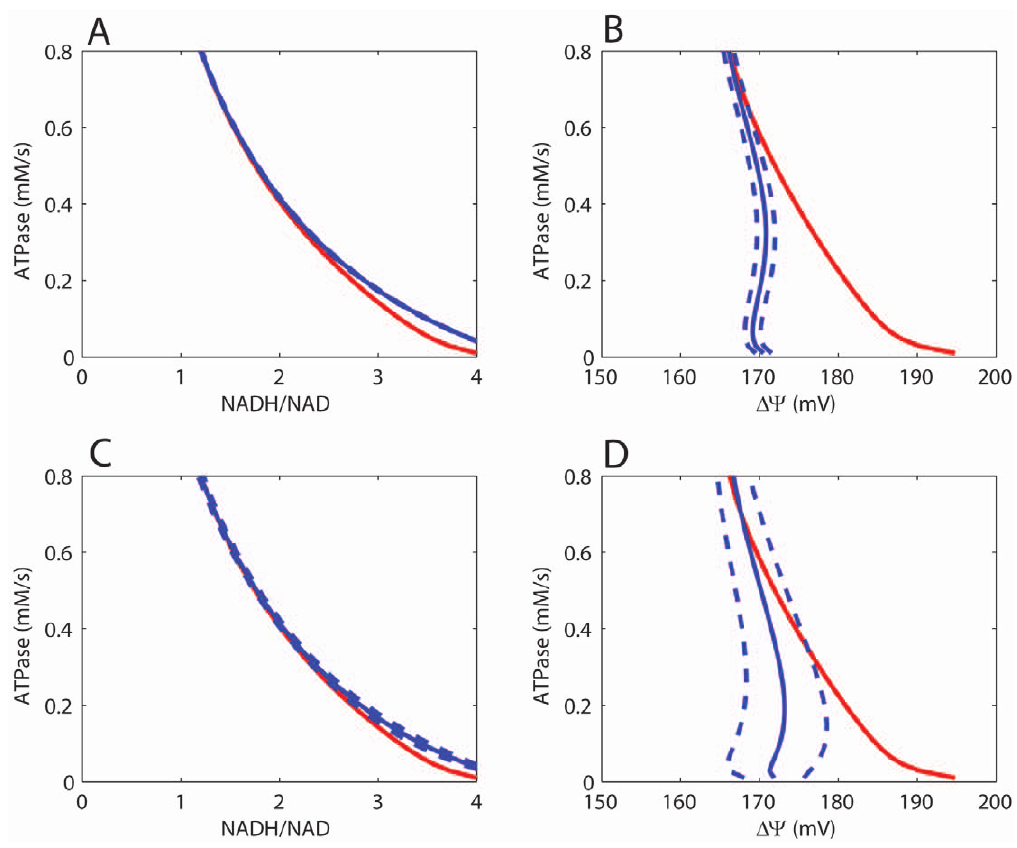
Figure 4. Model predictions of mitochondrial redox state (NADH/NAD) and membrane potential ( n Y ). Model predictions of mitochondrial redox state (NADH/NAD) and membrane potential ( n Y ) at different cellular ATP demand fluxes according to model configuration i ( A–B ) and model configuration ii ( C–D ). Model predictions are indicated as the mean (solid blue line) and SD (dotted blue line) of the 1000 simulations that were run in a Monte Carlo approach. Predictions of the original model are shown in red.